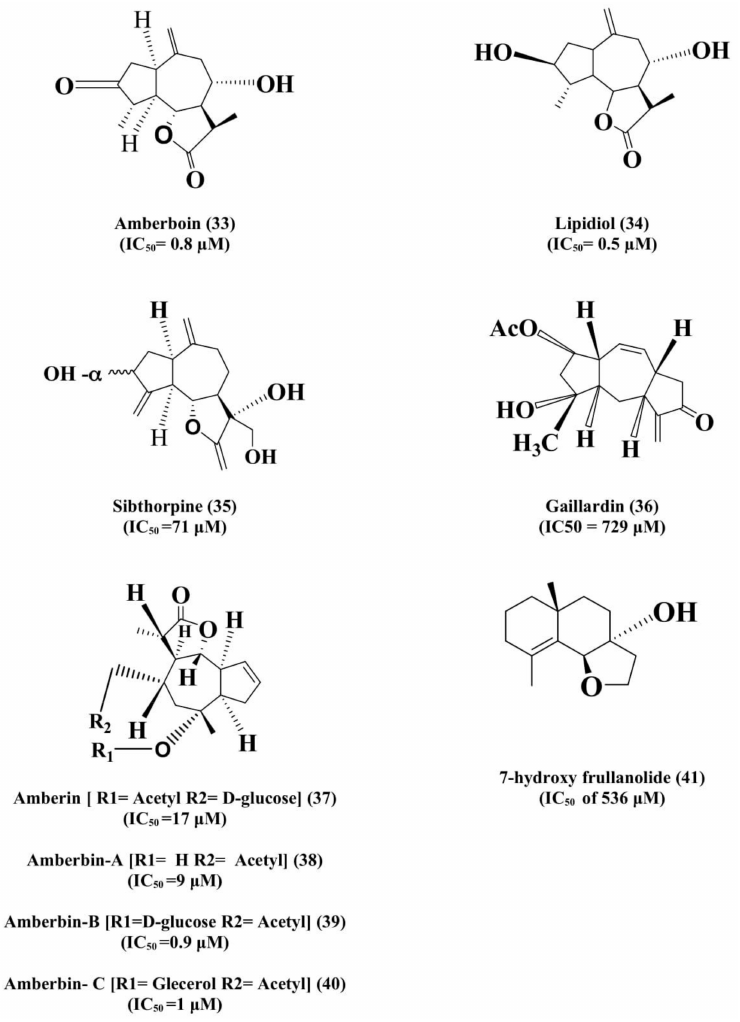
Figure 3. Sesquiterpene lactones/their derivatives for AChE